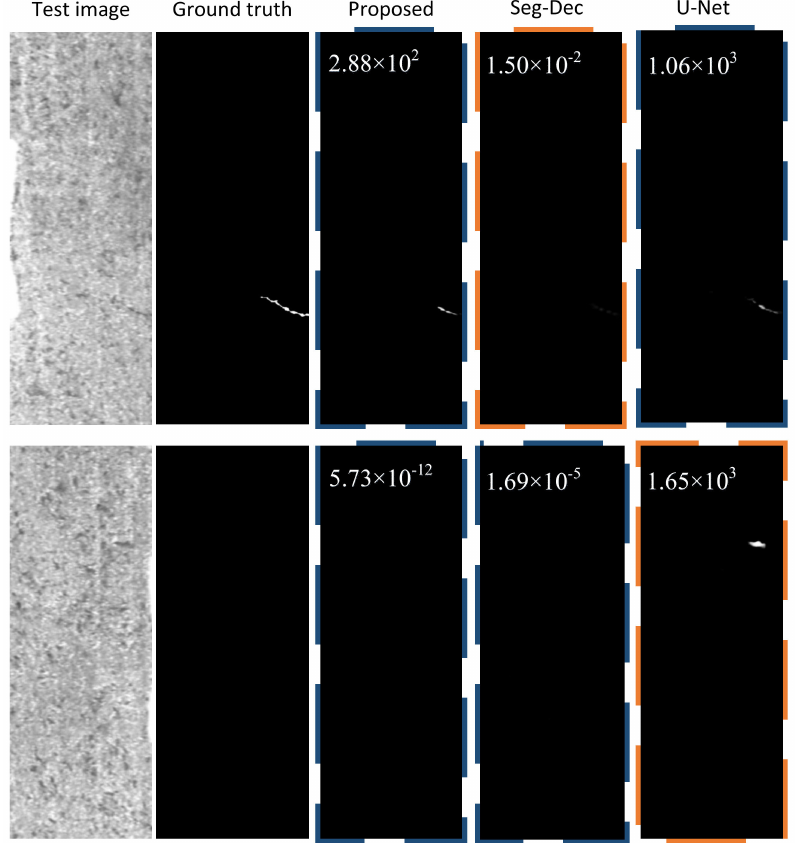
Figure 8. Examples of comparison experiments. Blue dashed border denotes true positive (TP) and true negative (TN), and orange dashed border signifies false positive (FP) and false negative